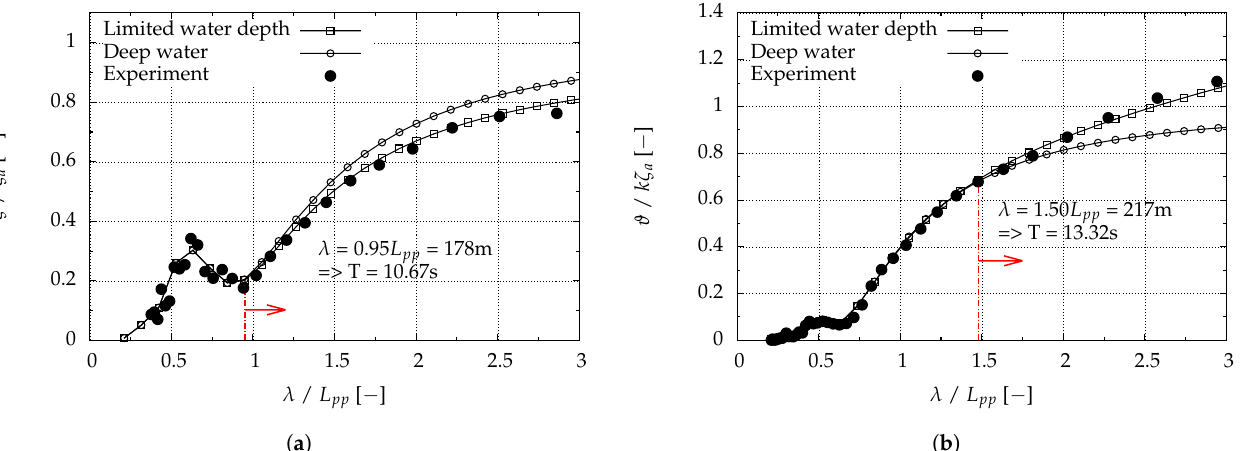
Figure 9. LNG carrier: with Green functions boundary element method computed effects of water depth on ( a ) heave and ( b ) pitch motions.